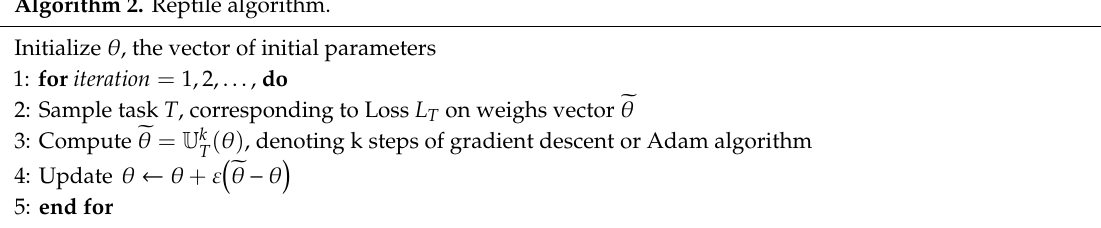
Algorithm 2. Reptile